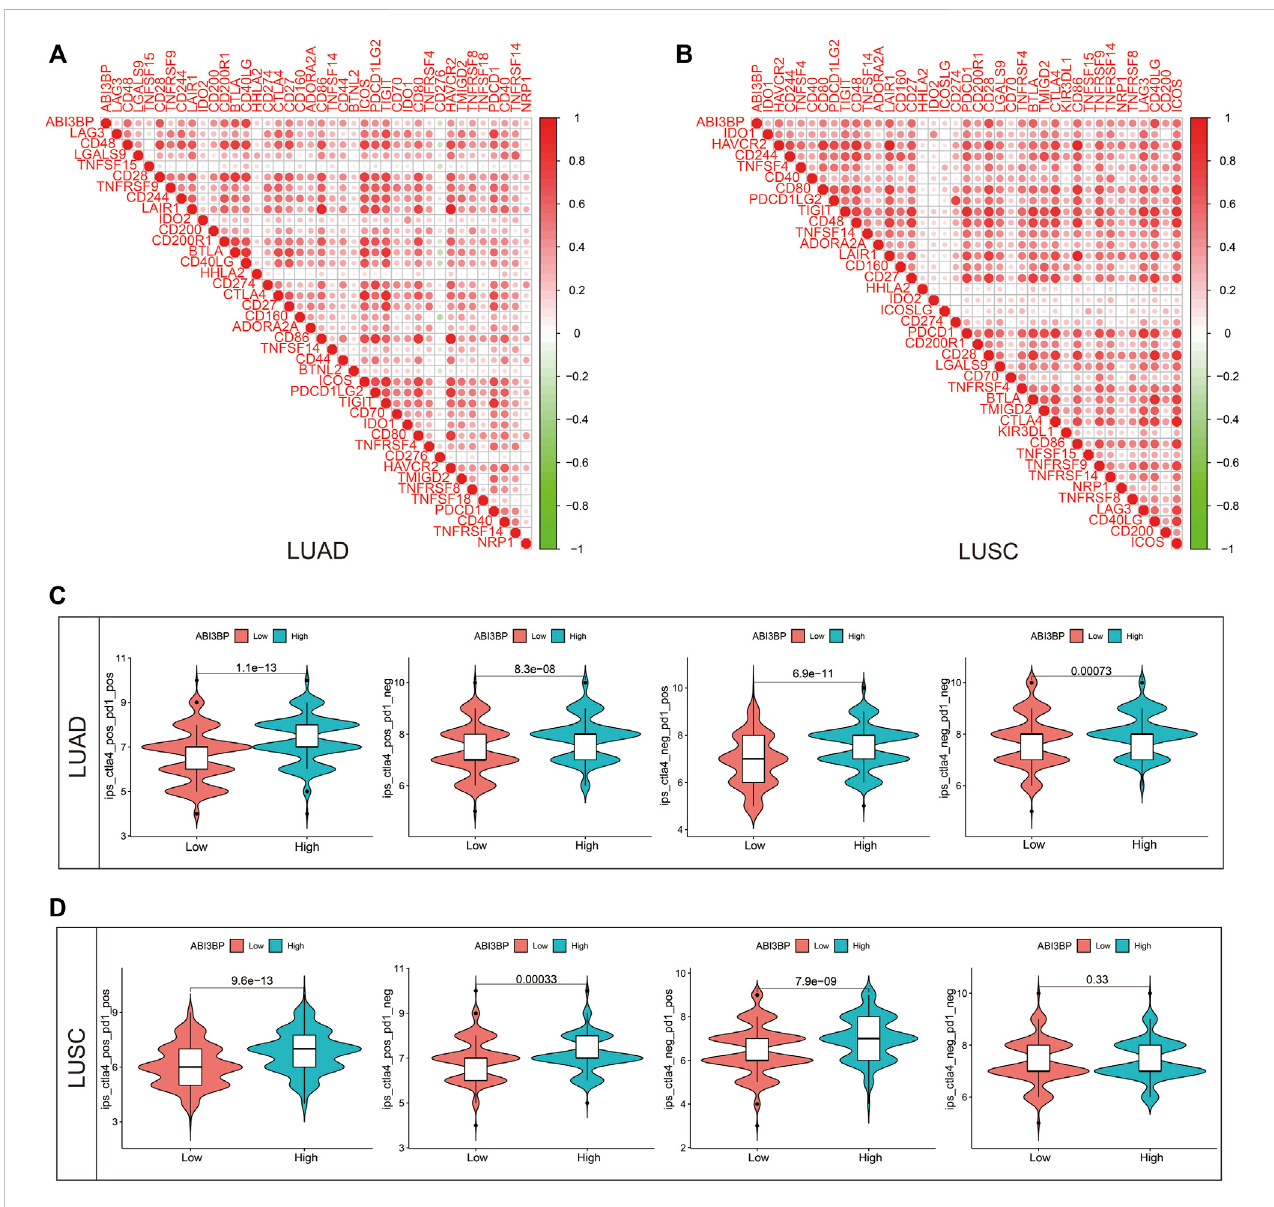
FIGURE 10 Therapeutic value of ABI3BP. (A,B) Relationship between ABI3BP and immune checkpoints. (C,D) ABI3BP and sensitivity to immunotherapy response inLUAD and